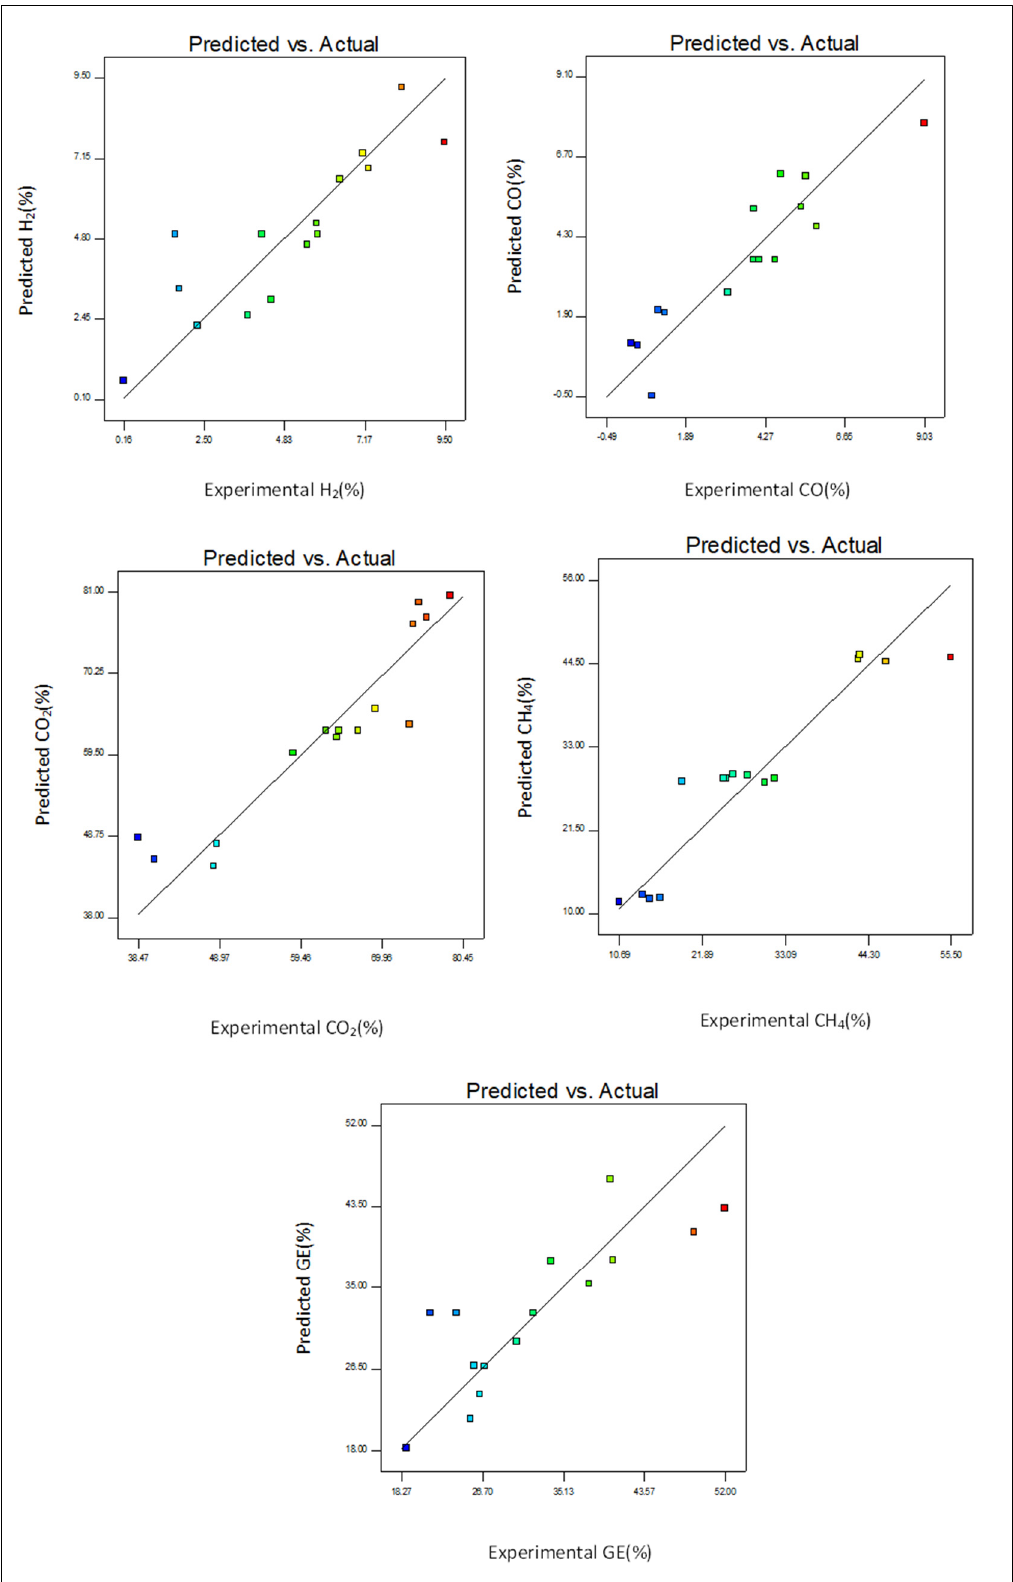
Figure 9. Predicted vs. actual response variables values.